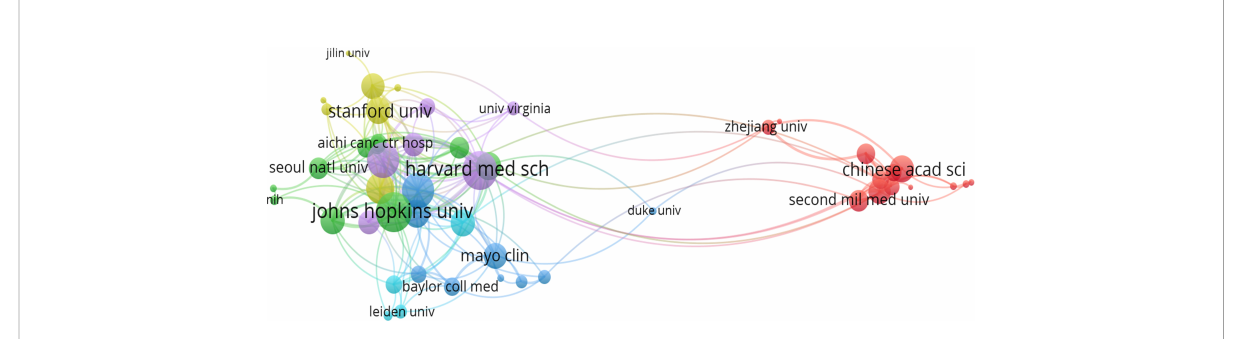
FIGURE 4 Analysis of co-authorship among institutions with more than fi ve publications. Clusters were identi fi ed by color, the size of the circles represented the number of publications, and the thickness of the lines showed the strength of the